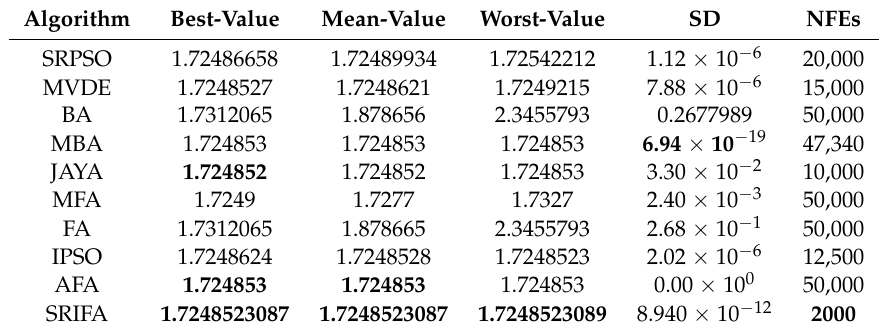
Table 12. Statistical results of comparison between SRIFA and NIAs for welded-beam